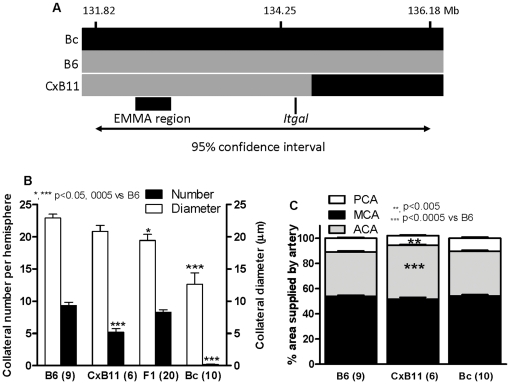
Collateral extent in CXB11.HiAJ (CxB11) confirms importance of Canq1.
A, Inheritance patterns of Cang1 on chromosome 7 in CxB11 recombinant inbred line derived from BALB/c (Bc)×C57BL/6 (B6). Y axis, SNP positions (Build 37). CxB11 inherits from B6 the segment (B6, grey; Bc, black) that includes the EMMA region and extends through Itgal. B, Collateral number is intermediate between B6 and Bc in CxB11 and significantly different from B6xBc-F1. C, Territory of cerebral cortex supplied by the ACA, MCA, and PCA trees. B6 and Bc are identical (confirms Zhang et al. [9]), while CxB11 has smaller MCA and PCA and larger ACA territory than B6. These differences do not correlate with variation in collateral number or diameter in these or 15 other strains [9]. Numbers of mice given in parentheses in this and other figures.